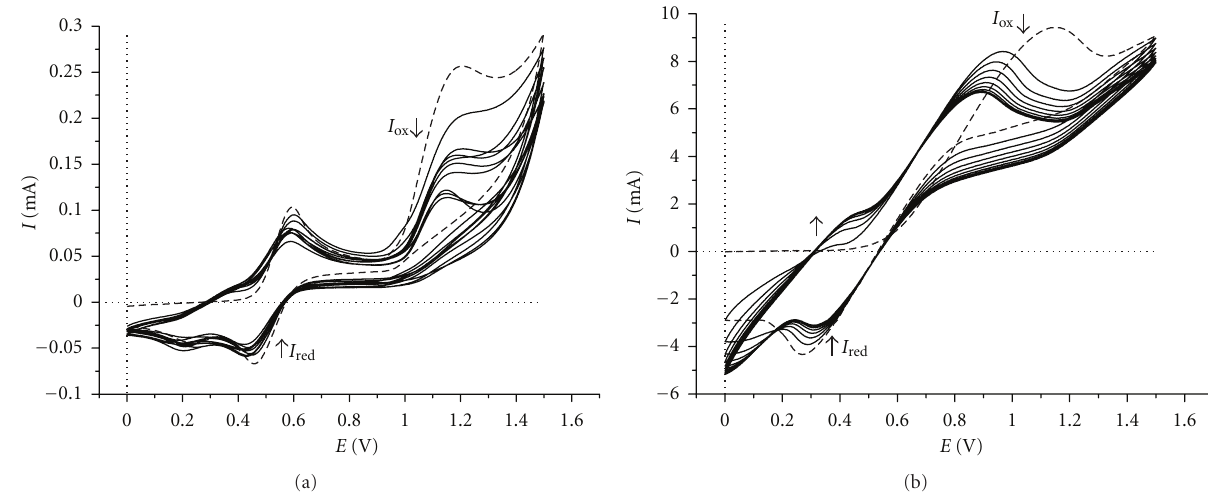
Figure 9: Multicyclic voltammograms (20 cycles) of DAnPS-aniline (1:3 ratio mixture) (10 − 2 M) in DMF-HCl (1M) aqueous solution at (a) Pt plate (1.0 × 0.5cm 2 ) and (b) ITO glass (2.5 × 2.5 cm 2 ) as working electrodes; the dotted line represents the first cycle. Scan rate: 50mVs − 1 .